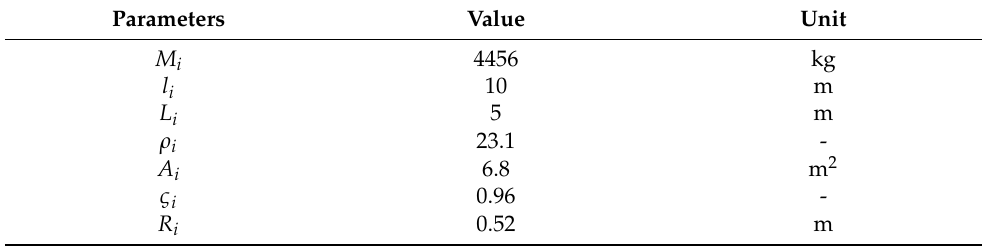
Table 1. Vehicle